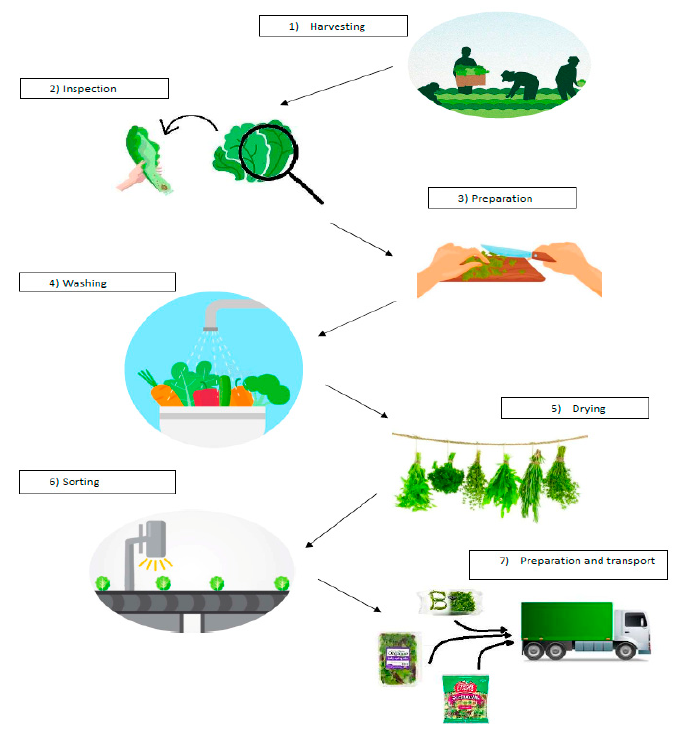
Figure 3. Salad crop production process.